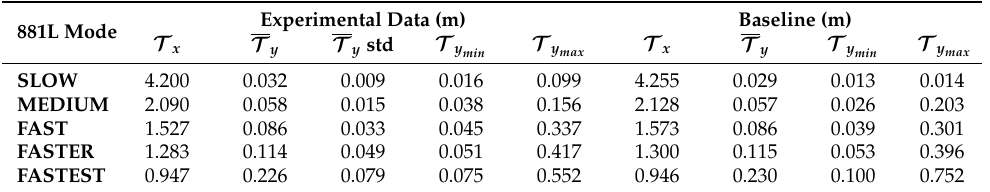
Table 3. VITA1 with one 881L sensor and range of 10 m: T y = sampling dist. along the tunnel cross section; T y = mean; T y = min.; T y = max.; T x = dist. between samples along the tunnel max min